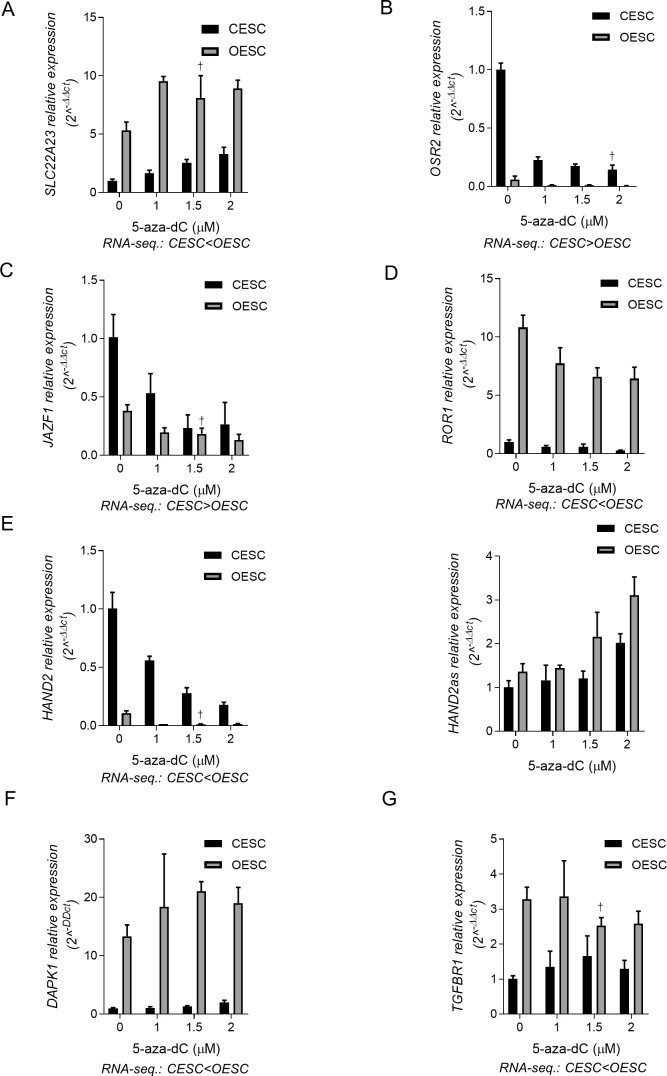
Validation of RNA-sequencing by Q-PCR and effects of 5Aza-dC on a subset of DM and DE genes in CESC and OESC.This figure shows average gene expression levels in CESC and OESC, from two or three biological replicates, after treatment with 5aza-dC for 72 hrs. All values were normalized to the mean of the non-treated CESC controls (0) set to 1. A) The relative expression of SLC22A23 under treatment with 5aza-dC increases in CESC as well as in OESC. In CESC, the increase in expression is dose dependent. B) The relative expression levels of OSR2 are decreased in CESC as well as in OESC under all tested doses of the demethylating agent. C) Treatment with 5aza-dC is associated with decreased relative expression levels of JAZF1 in both control and endometriotic stromal cells. D) Although in both CESC and OESC the ROR1 expression levels decrease under 5aza-dC treatment, in CESC the effect on gene expression is dose dependent and more pronounced compared to the endometriotic cells. E) While the HAND2 gene relative expression levels decrease after demethylation treatment as shown in the left bar graph, the HAND2as levels change in the opposite direction; the expression levels are increased in both CESC and OESC, especially at the highest level of 5aza-dC. DAPK1
(F) and TGFBR1
(G) expression levels are not influenced by the drug in CESC or in both CESC and OESCs, respectively. For direct comparison of Q-PCR and RNA-seq data, the differences in expression between CESC and OESC, identified by RNA-seq method are indicated below each graph. CESC, control endometrial stroma cells, OESC, ovarian ectopic endometriosis stroma cells. In each graph, † indicates conditions with biological duplicates.